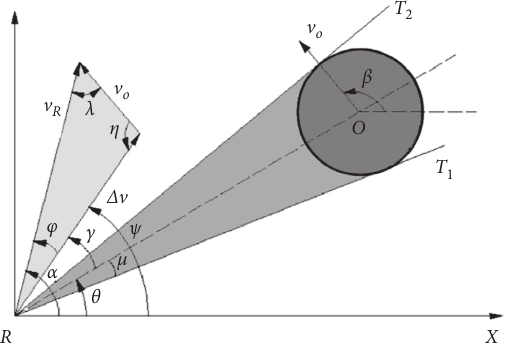
Figure 2: The intelligent ship and the velocity